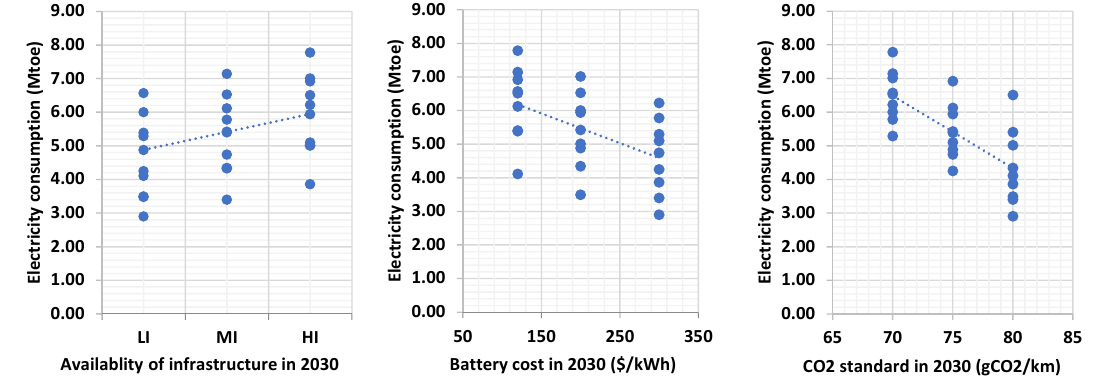
Figure 6. The distribution of electricity consumption of cars in the EU in 2030.